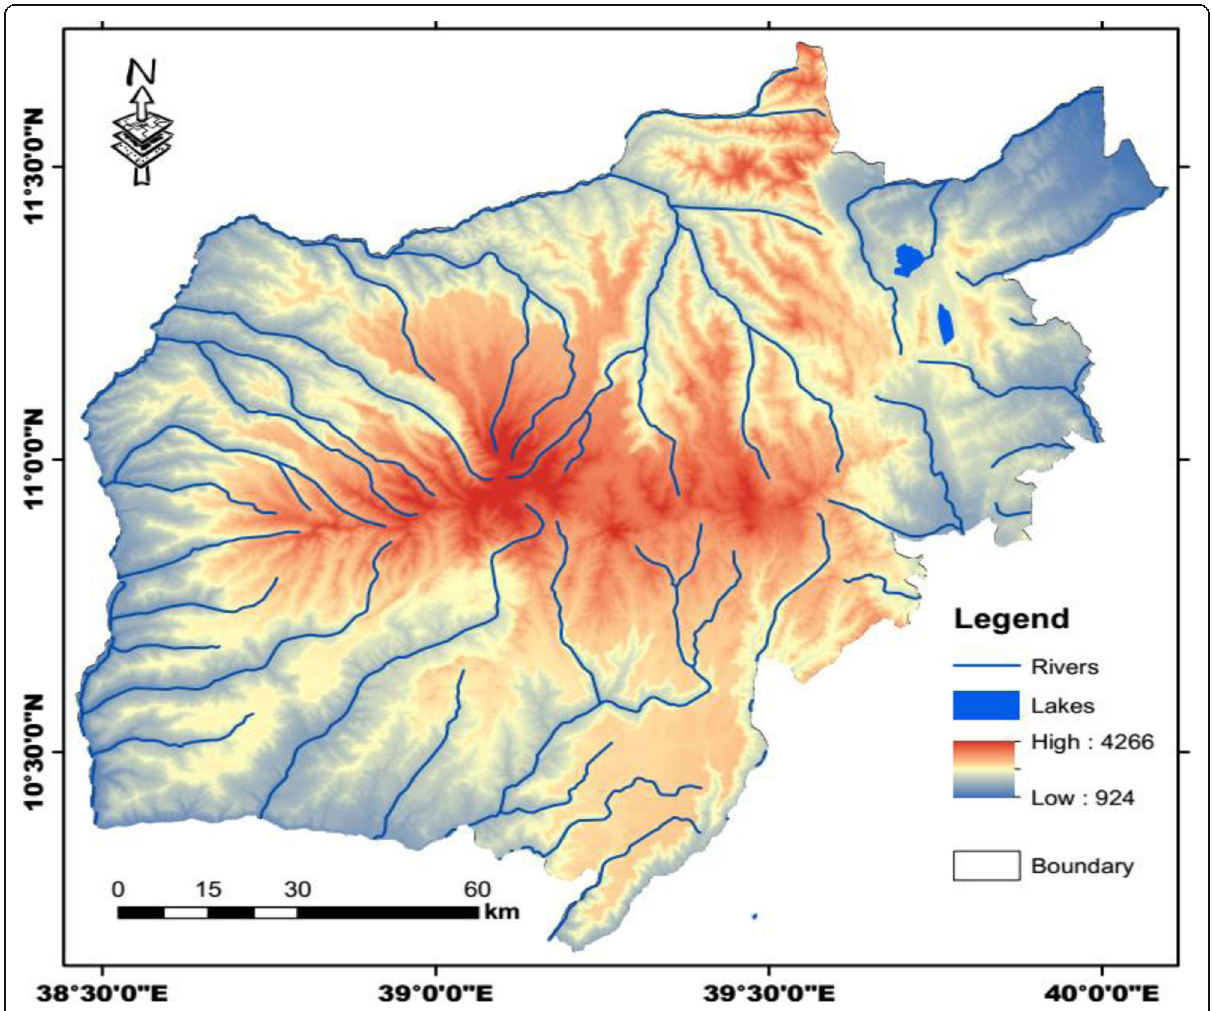
Fig. 5 Pattern of the major river and lake drainage systems in relation to the elevation of South Wollo administrative zone